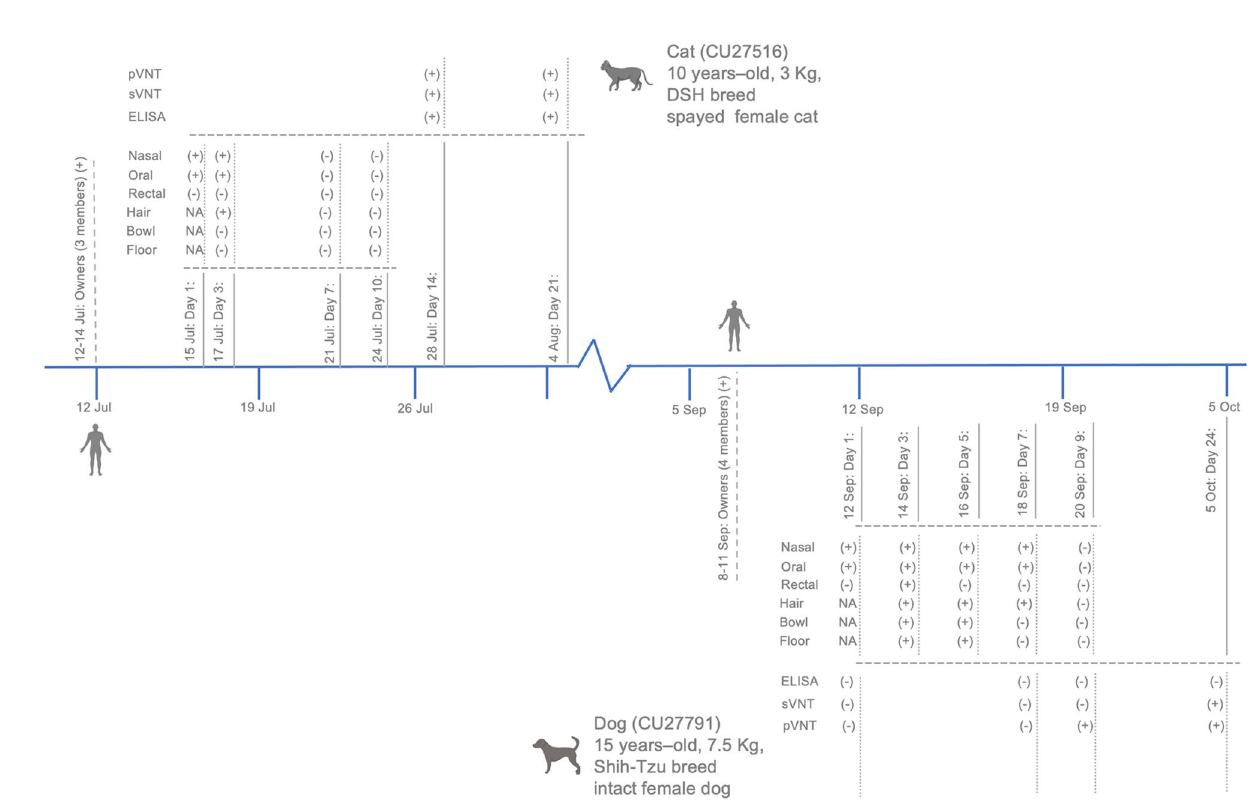
Figure 1. Timeline of SARS-CoV-2 detection in domestic dog and cat from covid-19 positive households in this